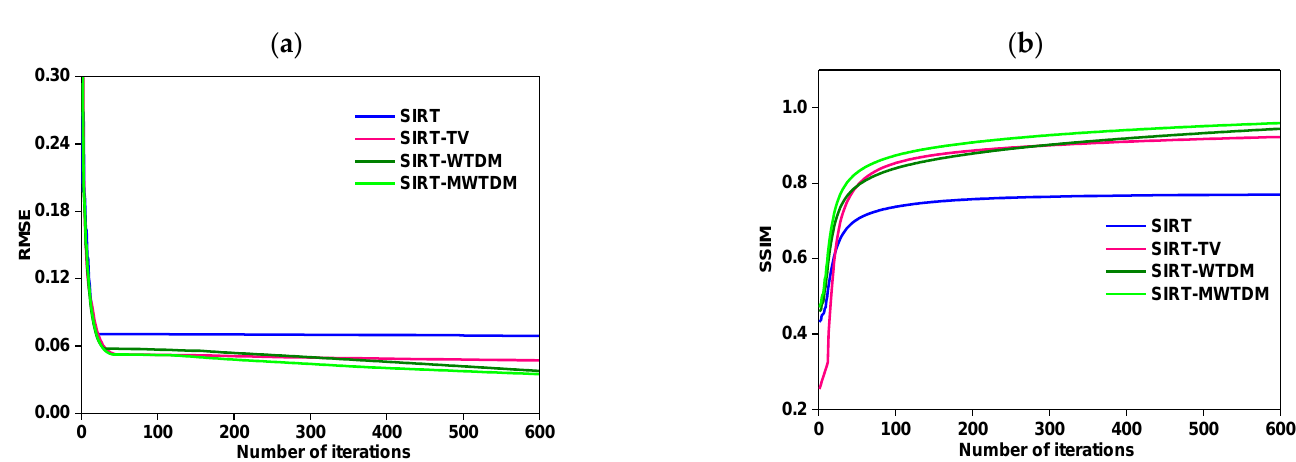
Figure 15. The RMSE and SSIM change curves of reconstructed images with different algorithms for 30 projections of the circular phantom. ( a ) RMSE; ( b ) SSIM.